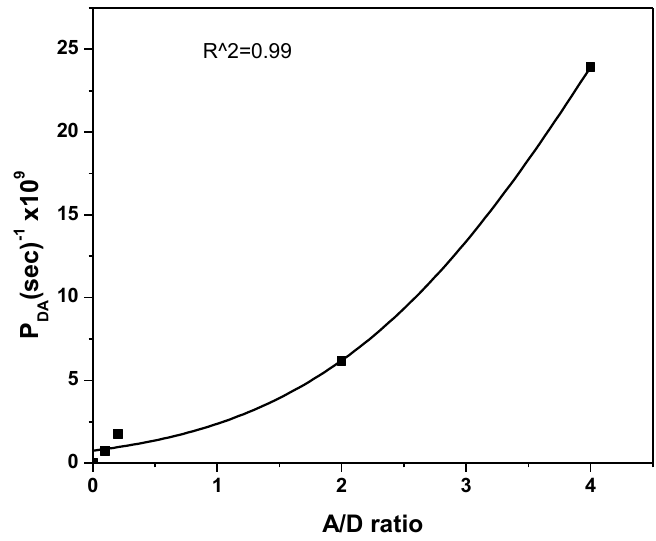
Figure 7. Energy transfer probability for 0-D Cs 4 PbBr 6 / MEH-PPV hybrid thin films.